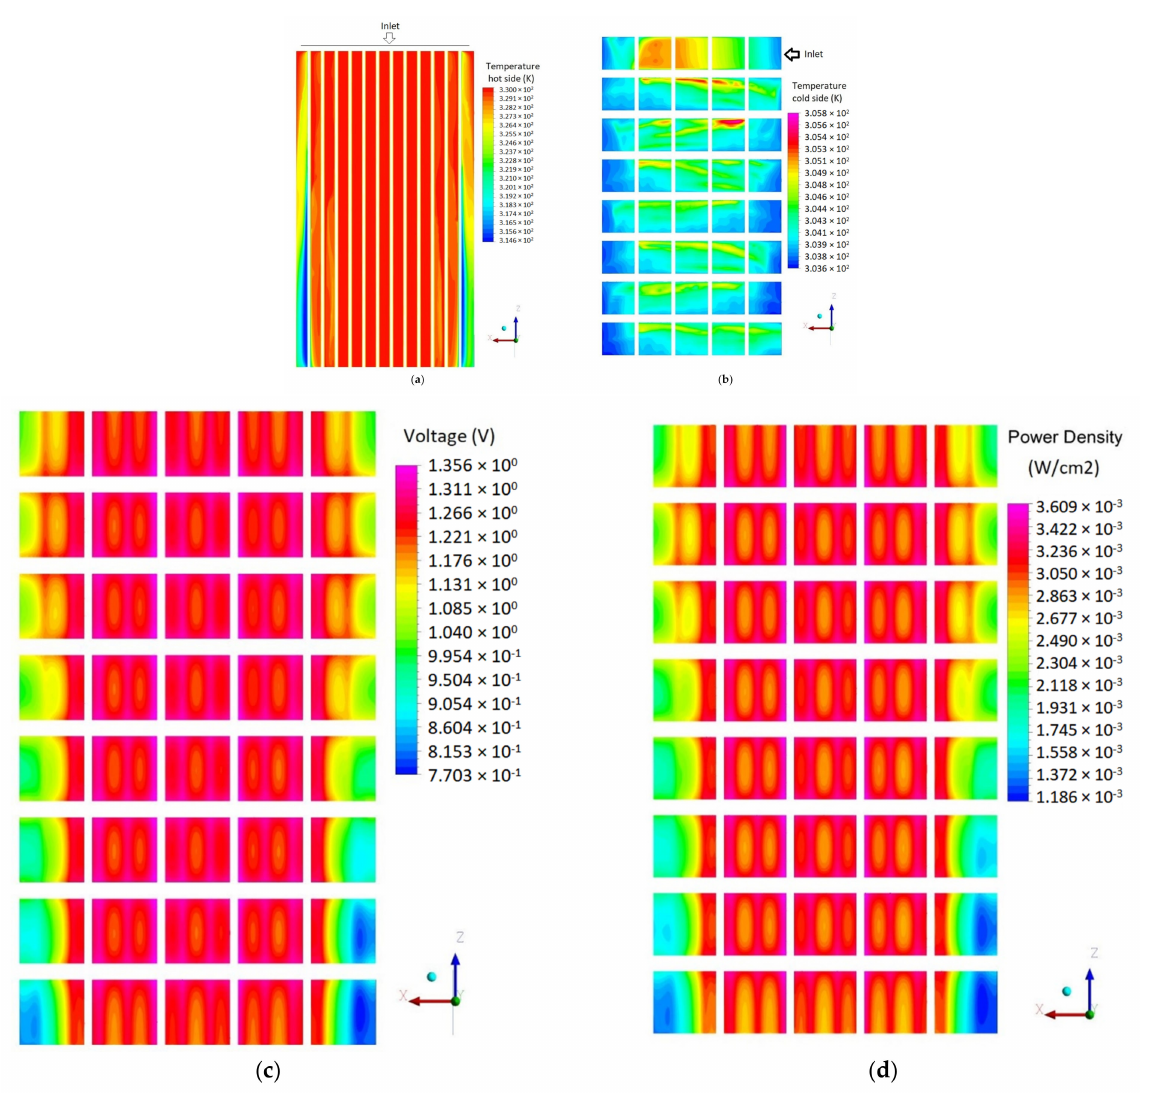
Figure 15. The contours simulated by the TEG unit model: ( a ) temperature on the hot side of the TEG that is in contact with the water flow from the PEMFC’s; ( b ) temperature on the cool side of the TEG fed with cooling water at 30 ◦ C; ( c ) voltage distribution in the TEG; ( d ) spatial distribution of electrical power in the TEG considering the surface are of 117 cm 2 for each module of the TEG